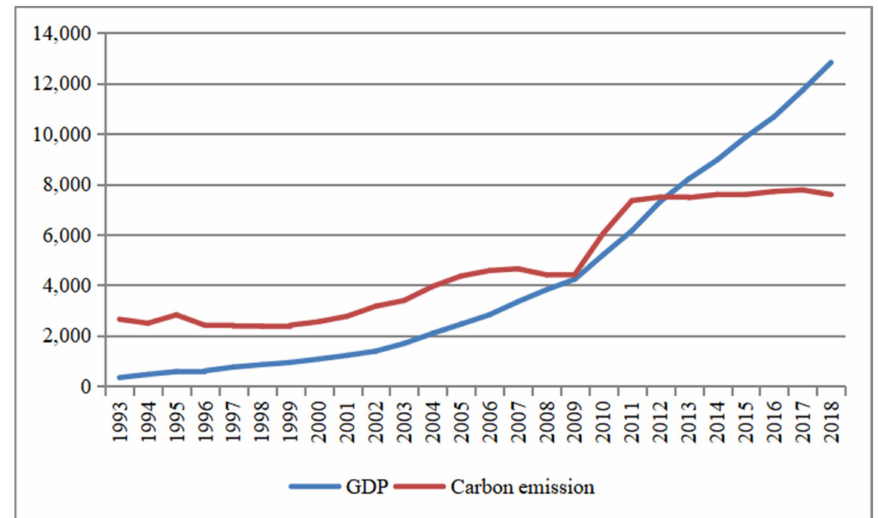
Figure 4. Overall trends in the GDP and carbon emissions. Table 3. Calculation of carbon emissions based on the total energy